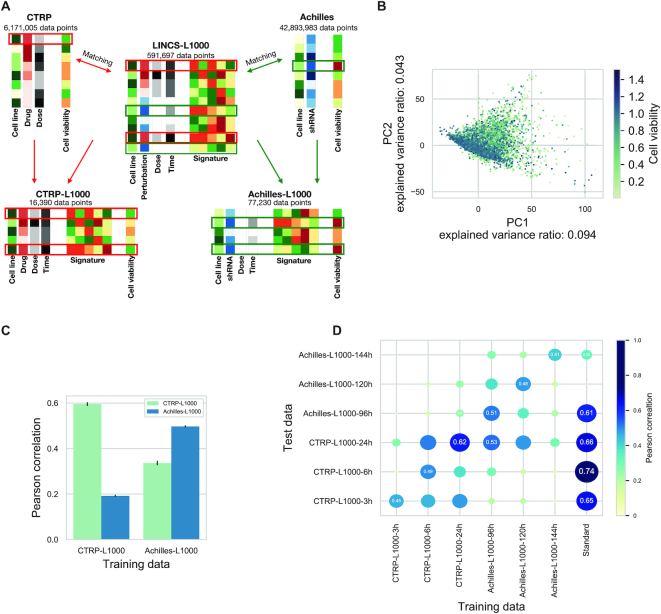
LINCS-L1000 perturbation signatures allow efficient prediction of cell viability. (A) Schematic representation of database matching pipeline. Perturbation signatures from LINCS-L1000 dataset were matched with cell viability data from CTRP and Achilles datasets based on metadata (cell line, perturbation and concentration). It is possible to match one CTRP/Achilles cell viability instance with more than one LINCS-L1000 signature (same cell line and perturbation but different perturbation time in LINCS-L1000). (B) Principal Component Analysis (PCA) of perturbation signatures from the CTRP-L1000 dataset. Each point represents a unique cell line–compound–concentration–perturbation time instance. Points are colored according to corresponding cell viability from CTRP screen (Spearman correlation between PC1 and cell viability: −0.278, P< 1e–300). (C) Prediction of cell viability using linear models. Linear models were trained on CTRP-L1000 and Achilles-L1000 datasets (x axis). Prediction performance was evaluated on CTRP-L1000 and Achilles-L1000 datasets (color coded) by calculating Pearson correlation (y axis) between predicted and observed values (results from 20 random sub-sampling validations, means ± SD). (D) The effects of perturbation time on the predictability of cell viability. Signatures from different time points (3, 6, and 24 h for CTRP-L1000 and 96, 120 and 144 h for Achilles-L1000) were used to train (x axis) and test (y axis) linear models. Standard models were trained on cell line–perturbation ID data. Size and colors of circles are proportional with the Pearson correlation, which is also labeled in selected cases (mean results from 20 random sub-sampling validations).